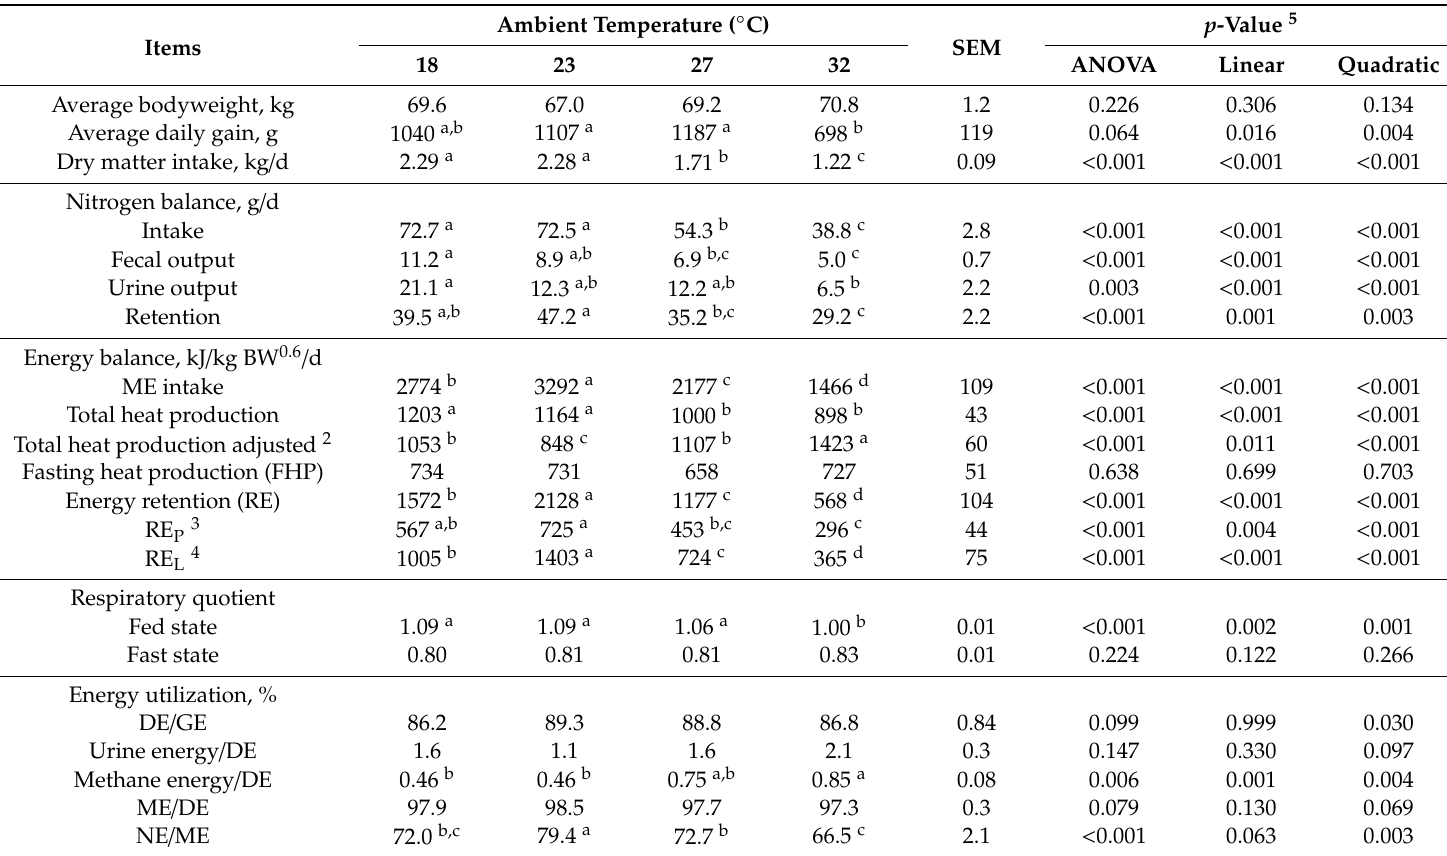
Table 3. Nitrogen and energy balance of barrows at 65 kg kept at di ff erent ambient temperatures 1